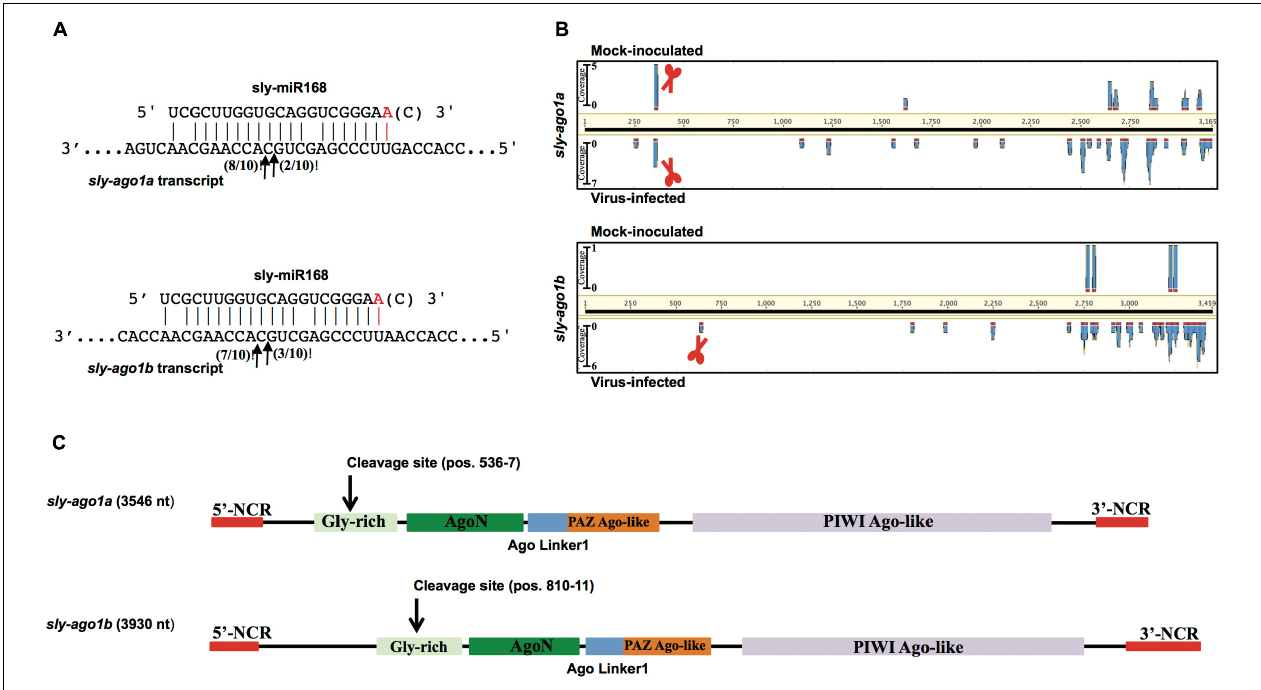
FIGURE 2 | Degradation patterns of sly-AGO1a and sly-AGO1 b. (A) 5 (cid:48) RACE of miR168-mediated cleavage of sly-AGO1a (NCBI seq ID NM_001279128.1) and sly-AGO1 b (NCBI seqID NM_001279332.2) in TYLCSV-infected plants (upper panel) and sly-AGO1a in mock-inoculated plants. Arrows indicate 5 (cid:48) -remnants found in the analysis and with numbers are the clones sequenced. In red or in brackets sly-miR168 found in the datasets ( Supplementary Table S1 ). (B) Degradation patterns of sly-AGO1a and sly-AGO1 b (upper and bottom panels, respectively) in mock-inoculated and TYLCSV-infected tomato plants (upper and bottom profile in each panel, respectively). Schematic scissors indicate the miR168 cleavage sites. (C) Graph of sly-AGO1a and sly-AGO1 b cDNAs showing the conserved protein domain and miR168 cleavage sites.